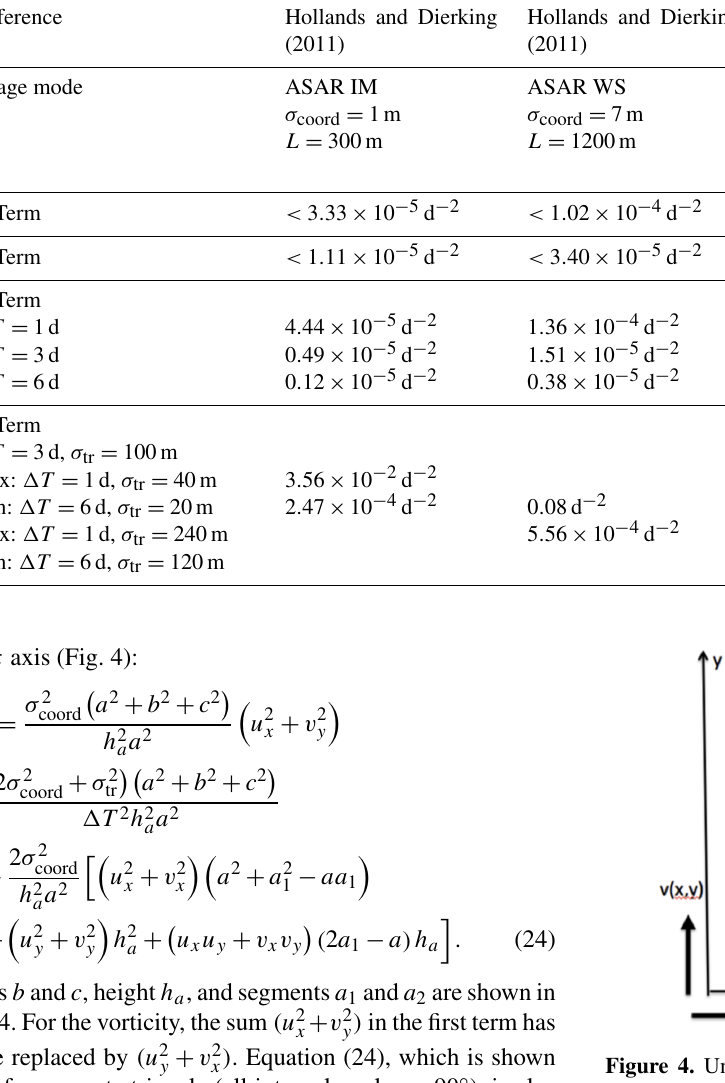
Table 1. Magnitudes of terms 1 to 4 in Eqs. (23) and (24). Reference